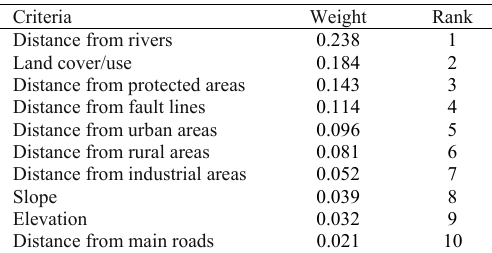
Table 5: The final weights for criteria land suitability assessment in Markazi province